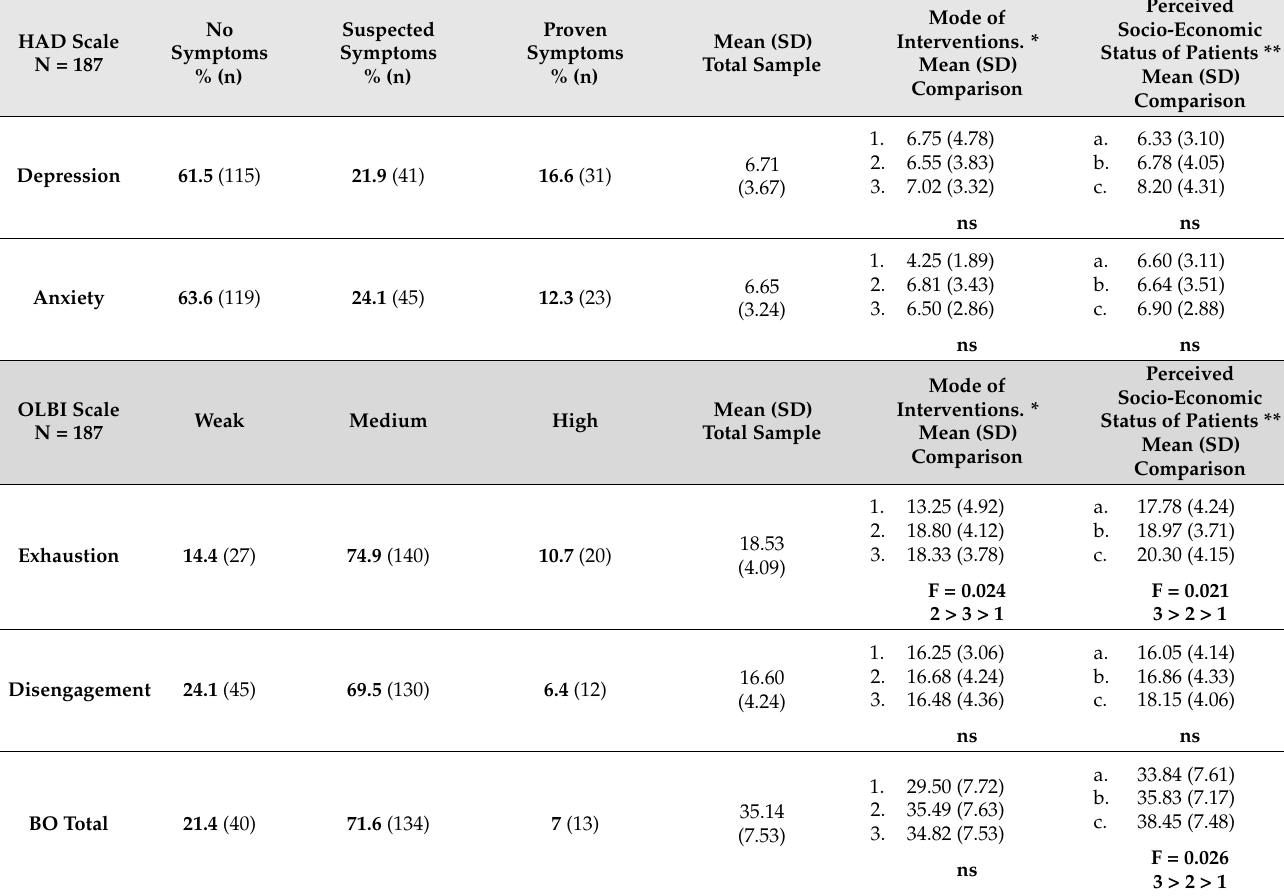
Table 4. Prevalence—Average HAD and OLBI scores and intergroup comparisons by work arrange- ments and socio-economic